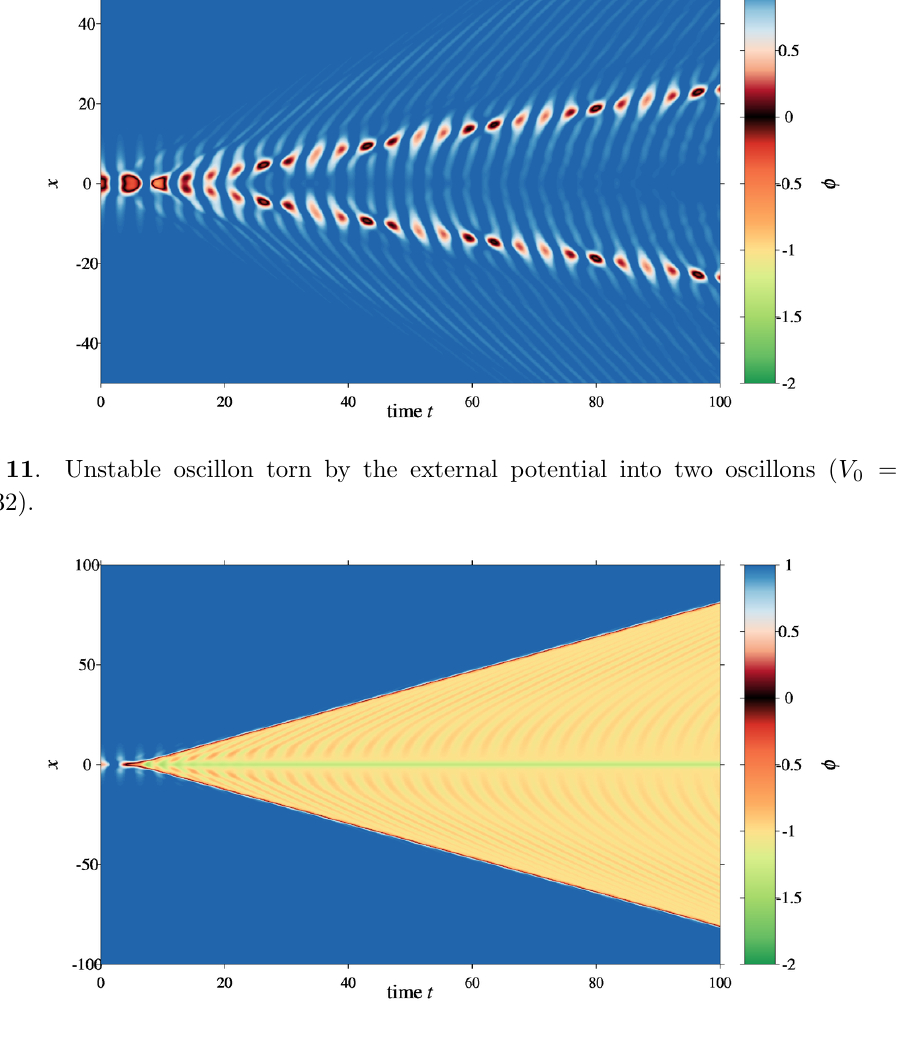
Figure 12 . K (cid:22) K production ( V 0 = 1 : 06, A 0 = 0 :